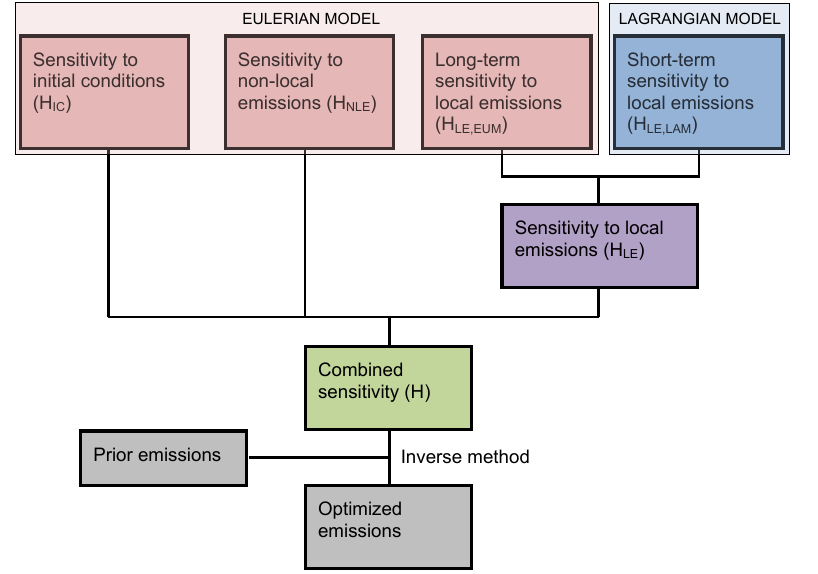
Fig. 3. Flow chart outlining the estimation procedure.